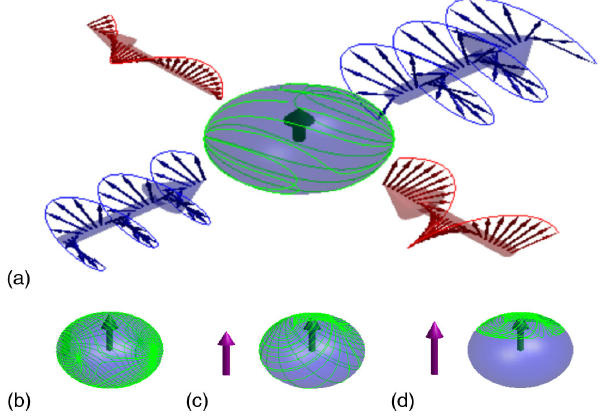
FIG. 1. We present a model that uses 2D topological insulator band structure as a guide to engineering the quantized energy pumping between different frequency modes. (a) A spin- 1 = 2 particle driven by two sources with incommensurate frequencies. In the topological phase, the spin trajectory (green line) fully covers the Bloch sphere (blue). The intermode coupling induced by the spin dynamics pumps energy from one drive (red) to the other (blue) at a nearly quantized rate. The lower panel shows effective magnetic-field trajectories for (b) m ¼ 0 (gapless phase between two topological ones), (c) m ¼ 1 . 8 (just inside the topological phase), and (d) m ¼ 2 . 2 (just outside the topological phase). The mass m is depicted as a purple arrow [static B z field; see Eq. (15) for the